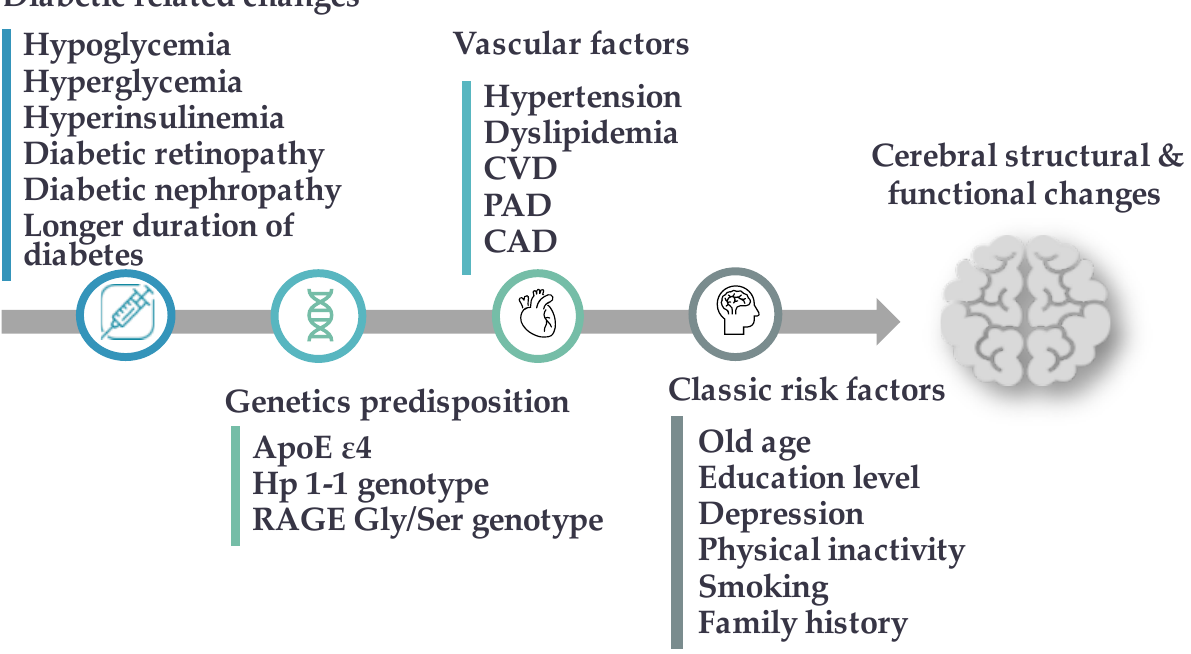
Cerebral structural & functional